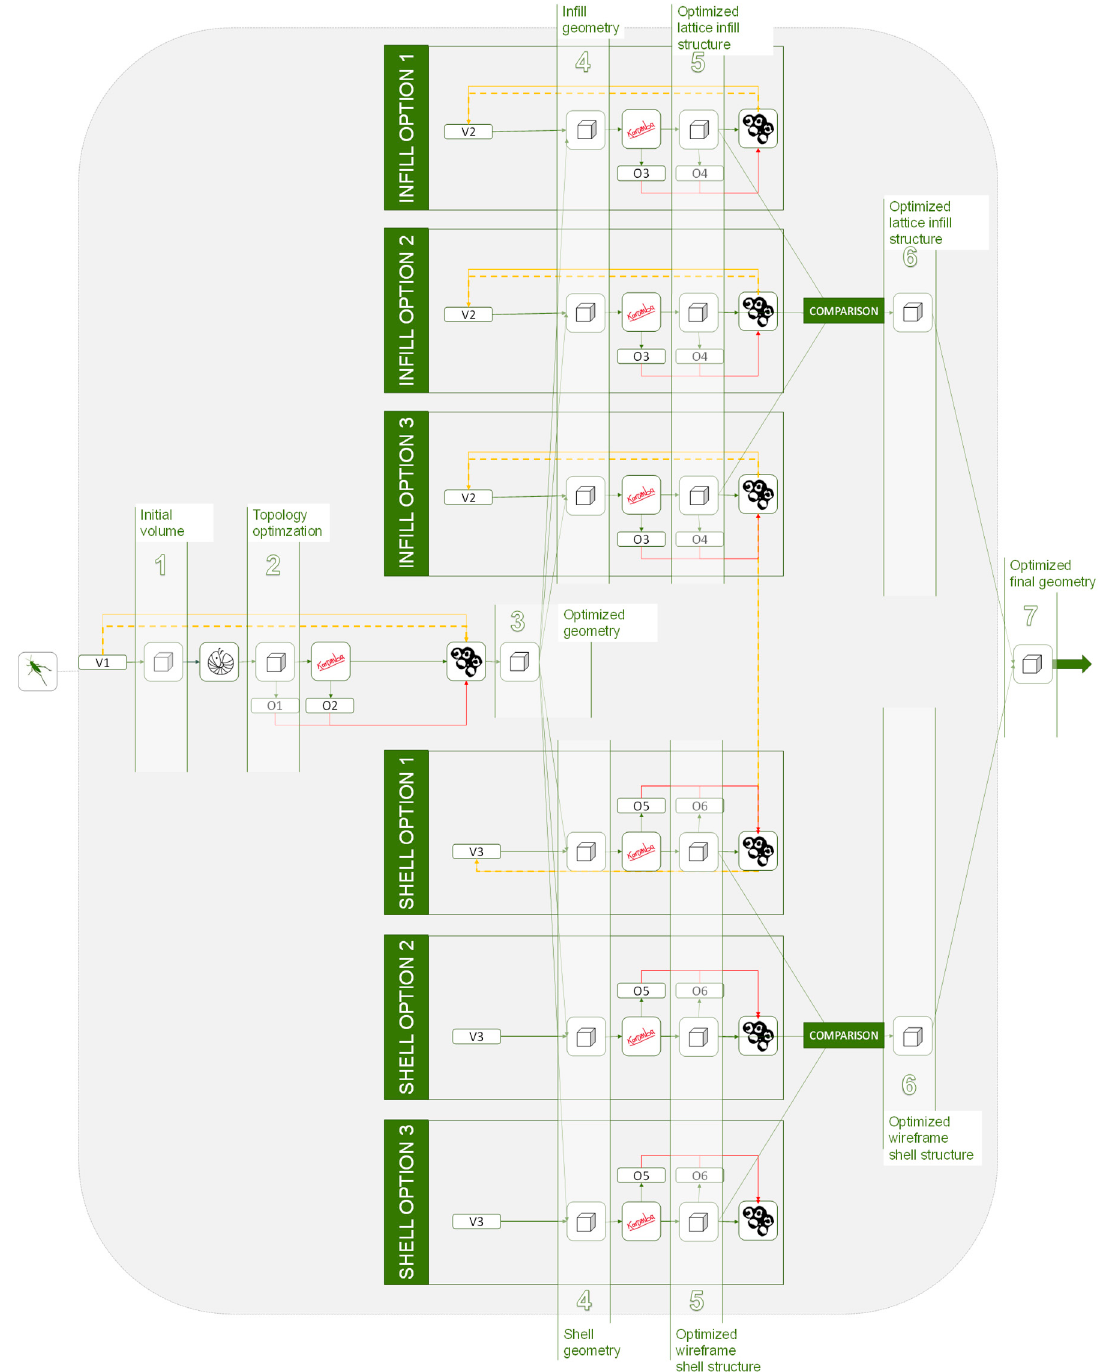
Figure 20. Hierarchical methodology applied to design alternatives .